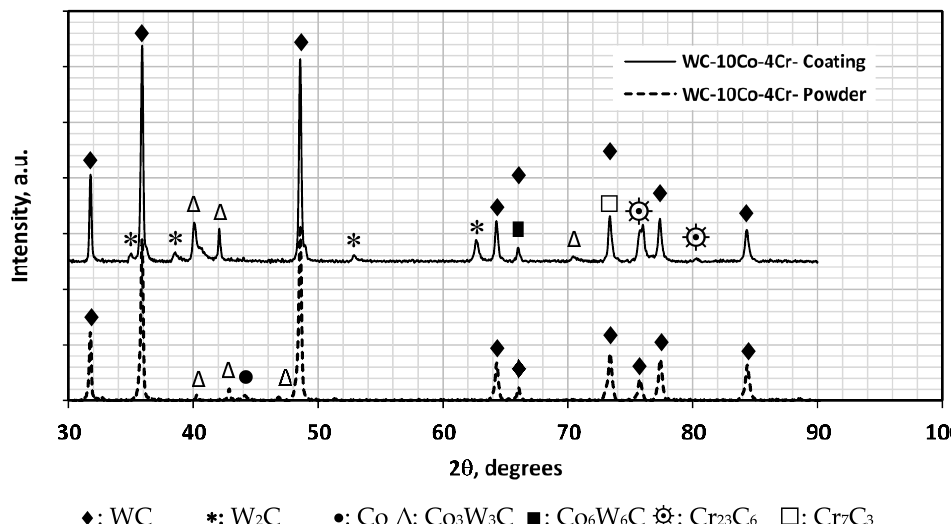
Figure 13. XRD-patterns of WC-10Co-4Cr in powder and coating conditions.